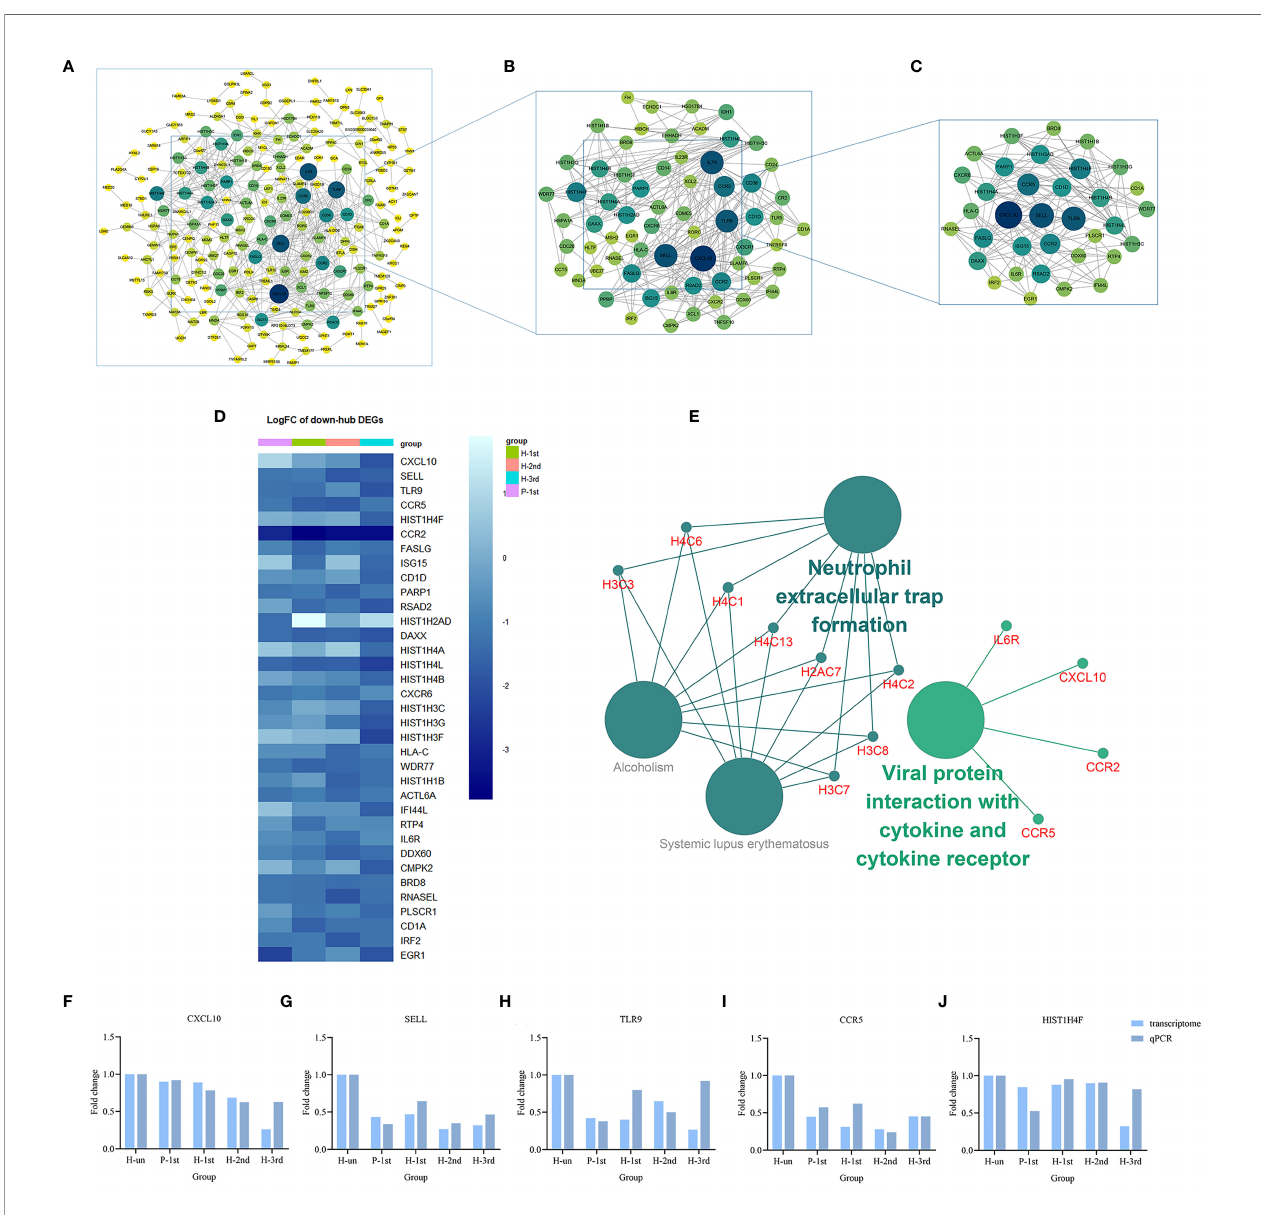
FIGURE 5 | PPI networks of the down-regulated DEGs in vaccination groups. (A) The PPI network of all down-regulated DEGs, consisting of 309 nodes. (B) PPI network extracted from A by Degree Centrality, consisting of 76 nodes. (C) The PPI network extracted from B by MCODE, consisting of 35 nodes. PPI, protein- protein interaction; DEGs, differentially expressed genes. (D) The differential expression of 35 characteristic down-regulated DEGs in the four vaccination groups. Each row represents mRNA and each column represents a group. (E) A total of four KEGG pathways of the 35 characteristic down-regulated DEGs. (F – J) Expression levels of CXCL10, SELL, TLR9, CCR5, and